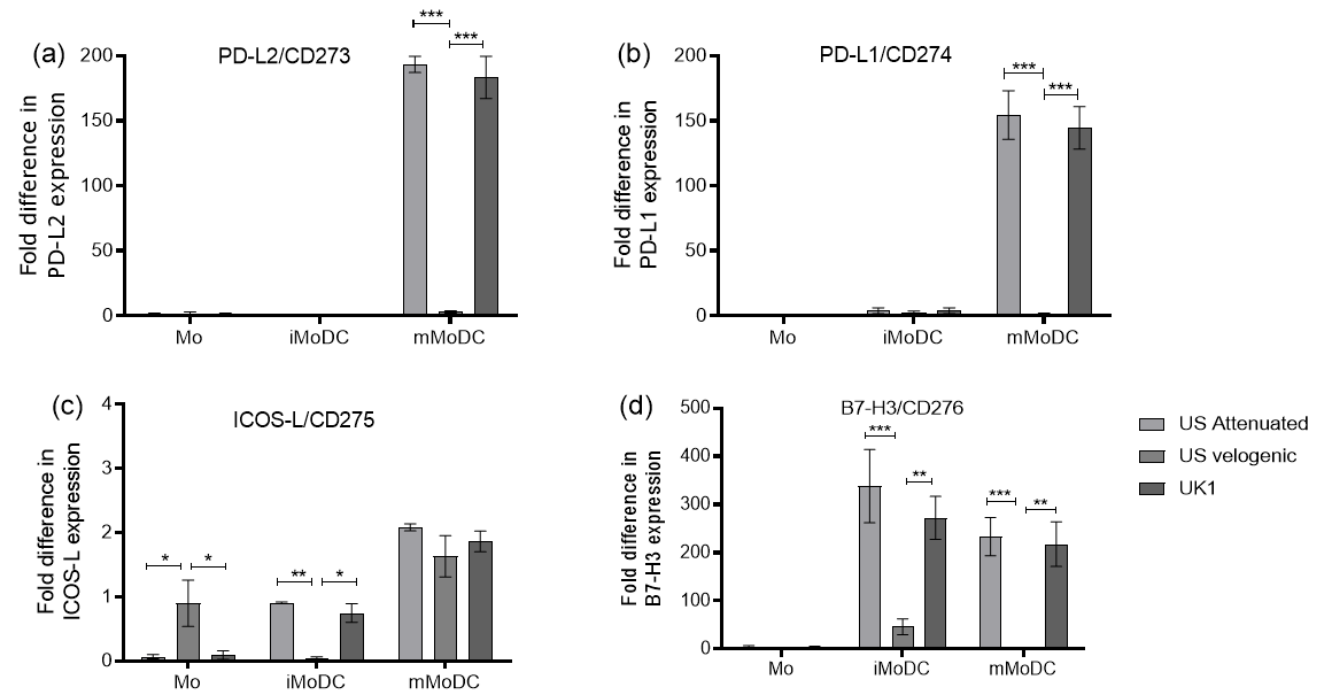
Figure 7. The expression level of costimulatory molecules on EAV infected Mo and MoDC. The co-stimulatory molecules, PD-L1/CD274, PD-L2/CD273, ICOS-L/CD275 and B7-H3/CD276, were assessed from EAV infected Mo and MoDC 16 hpi using duplex TaqMan qPCR assays with 18S rRNA gene as the reference. The normalized target gene expression was calculated by using the 2- ∆∆ Ct formula using the mock infected cells as comparator. There were significant differences in the expression of PD-L1/CD274 and PD-L2/CD273 on infected mMoDC with only the Attenuated and UK1 strains resulting in an upregulation ( a , b ). The overall expression differences of ICOS-L/CD275 on infected Mo and MoDC were low (less than 2-fold differences) ( c ). The expression level of B7- H3/CD276 on infected iMoDC and mMoDC was significantly different between strains ( d ). Results were represented as the average fold difference ± SEM ( n = 3). A 2-way ANOVA with Bonferroni post-test was used to compare replicate means. *, ** and *** indicate significant differences between sample means where p < 0.05, 0.01 and 0.001, respectively.